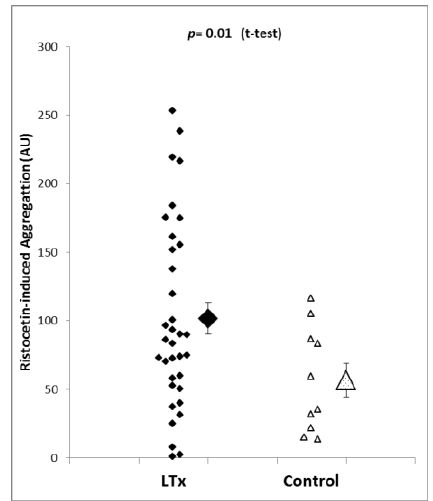
Figure 2. Ristocetin-induced platelet aggregation is significantly higher in liver transplantation patients ( n = 35) than in the control group ( n = 10). The results suggest the presence of a highly active von Willebrand factor in liver transplantation patients in comparison to control patients. Shown are individual measurements as well as mean and SEM.